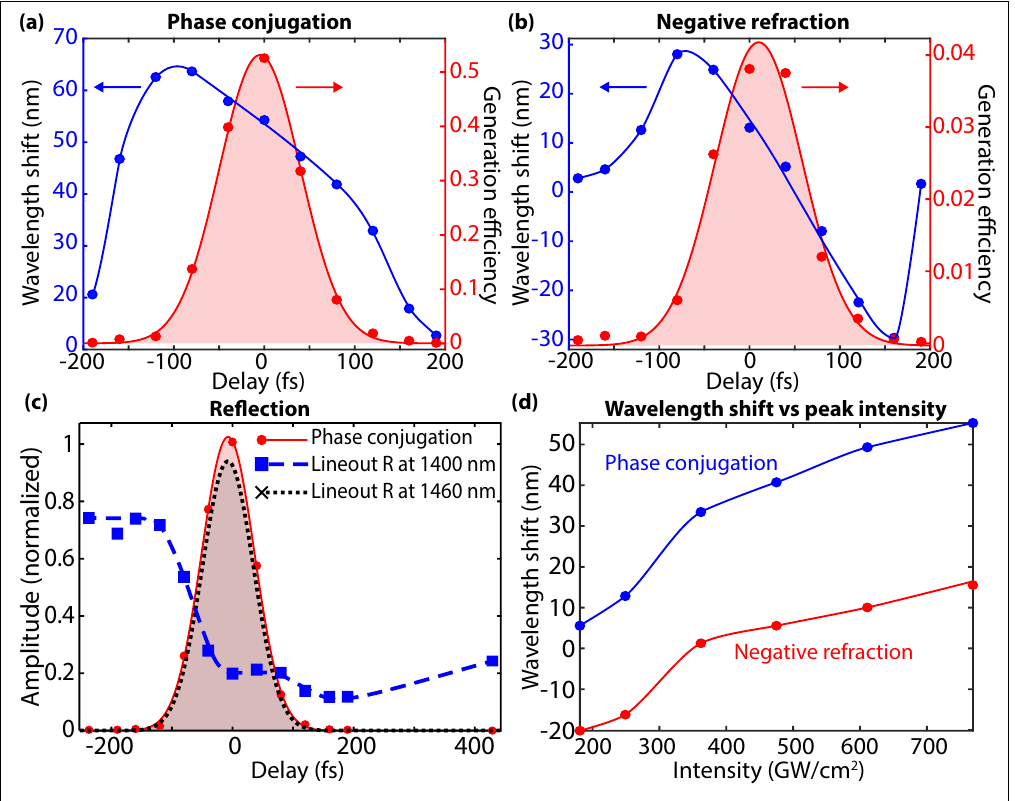
Figure 3. ( a ) Carrier wavelength shift of the PC signal as a function of the pump-probe delay ∆ τ (blue-curve) overlapped with the PC generation efficiency (red curve). ( b ) Carrier wavelength shift of the NR signal as a function of the pump-probe delay τ (blue curve) overlapped with the NR generation efficiency (red curve). ( c ) Reflection spectrogram as in Figure 2c, with a dashed blue line at the input seed carrier wavelength and a black dotted line at the carrier wavelength of the PC peak. ( d ) Measured wavelength shifts for the PC (blue) and the NR (red) nonlinear products, as a function of the pump